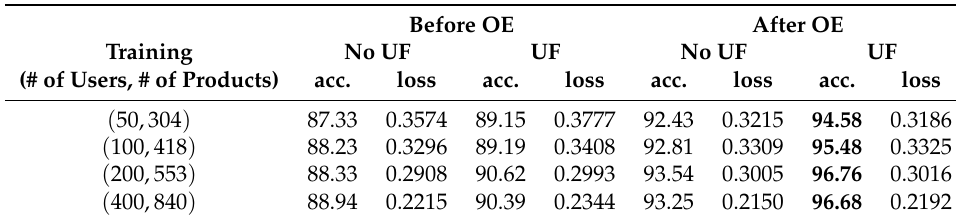
Table 5. Validation of the soft accuracy (acc.) and validation loss (loss) for the proposed NCFO hybrid recommendation architecture.